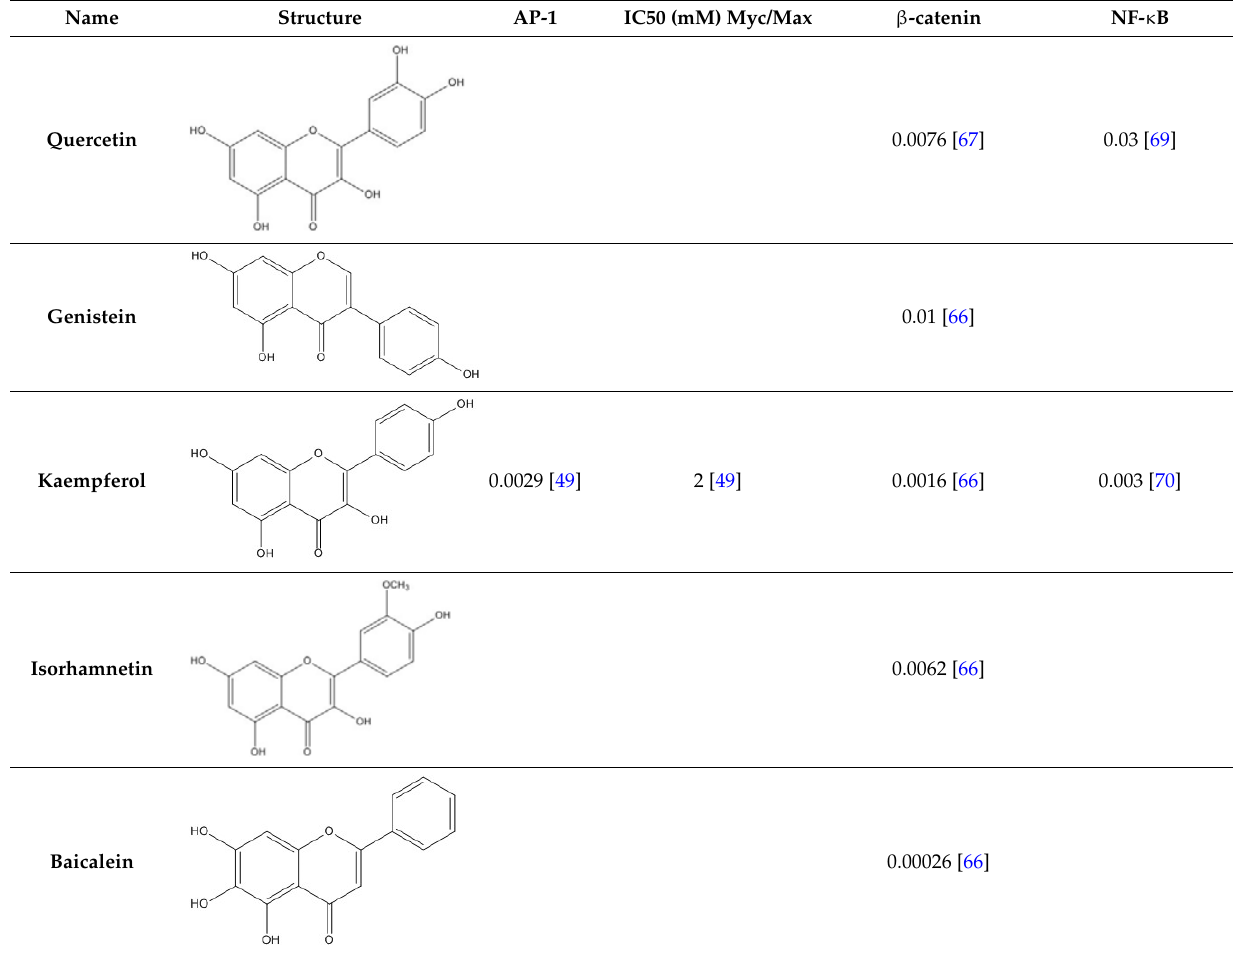
Table 3. Structures and activities of flavonoid inhibitors against transcription factors.